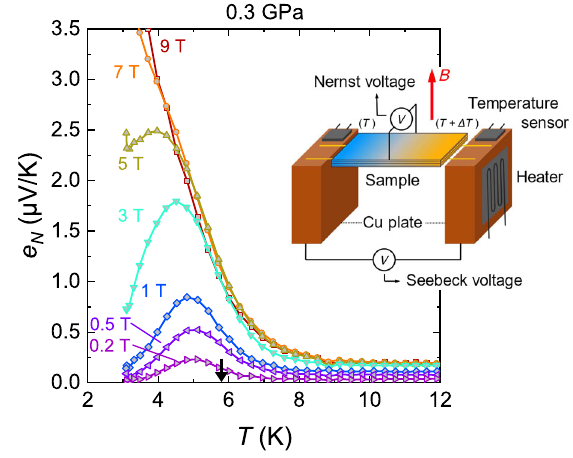
FIG. 6. Temperature dependence of the Nernst signal e N under a pressure of 0.30 GPa. The measurements were made at the magnetic fields of 0.2, 0.5, 1, 3, 5, 7, and 9 T applied perpendicular to the conducting layers. The arrow indicates the zero-field T c determined by the simultaneously measured thermopower. The geometry of the measurement setup is depicted in the